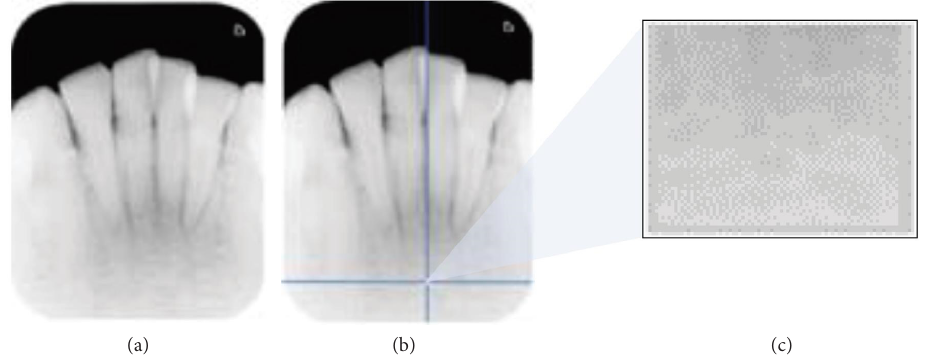
Figure 2: ROI selection: (a) original image, (b) starting point for ROI, and (c)